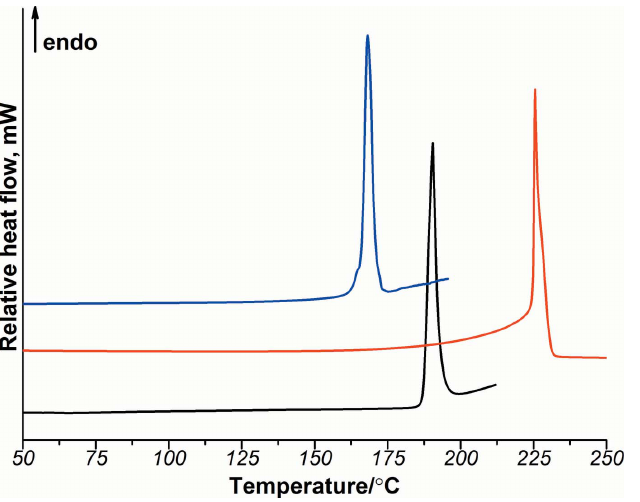
Figure 3 DSC curves of PABA (black), POA (red) and [PABA+POA] (blue).